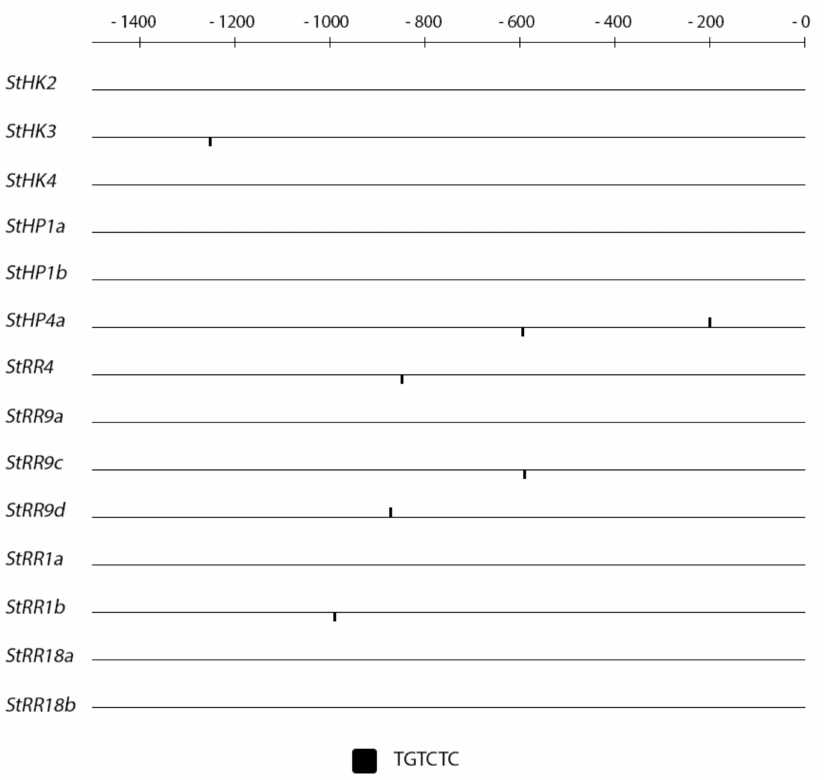
Figure 9. Pattern of auxin-specific cis -elements (AREs) in promoters of CK signaling potato genes. The scale on the top shows distance in bp upstream the transcription start. The position of ARE TGTCTC is shown; another ARE sequence TGTCGG is absent in these